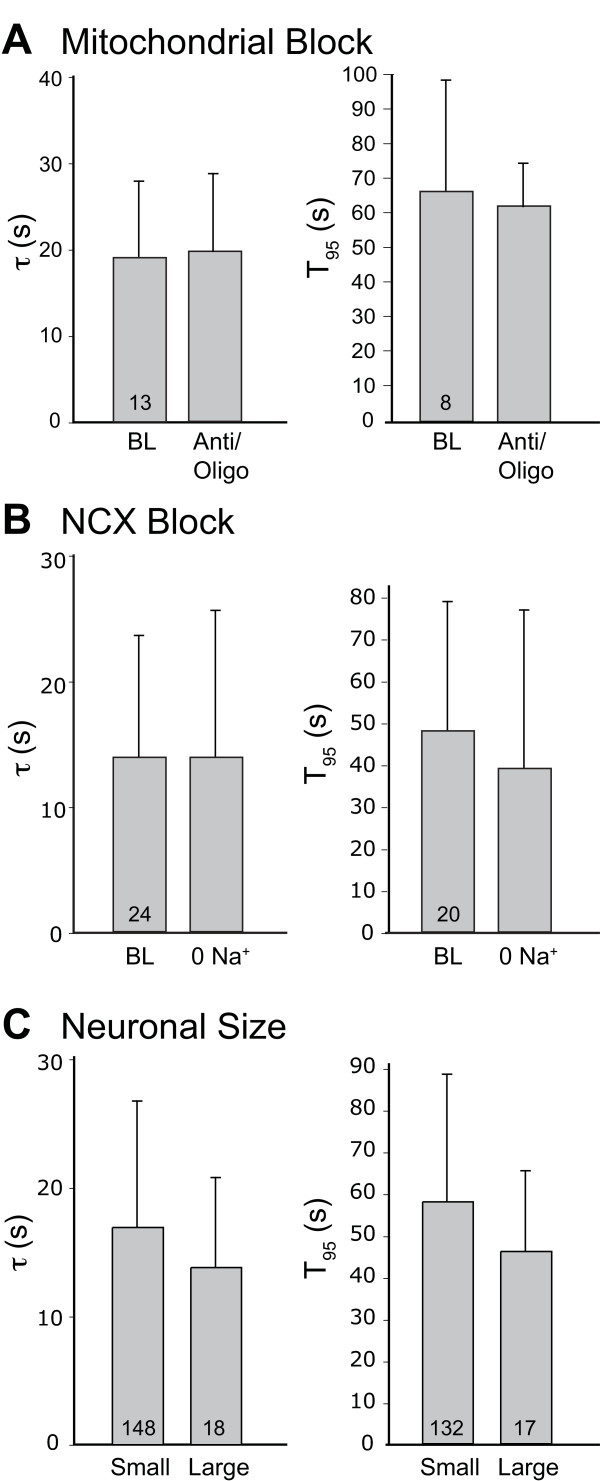
Roles of mitochondria, Na+/Ca2+ exchanger (NCX), and neuronal size. The recovery of [Ca2+]c from transients induced by application of high K+ solution (50 mM for 0.3 s) in thapsigargin-treated neurons was measured by recovery rate constant (τ) and by the time to achieve 95% recovery to baseline (T95). Blockade of mitochondrial function by combined application of antimycin (1 μM) and oligomycin (10 μM) for 3 min had no effect compared baseline values (BL) in the same neurons (A). Block of NCX by equimolar replacement of bath Na+ with N-methyl-d-glucamine (NMDG) also had no effect on recovery of transients (B). Neuronal groups with either large (diameter 39 ± 4 μm) or small (26 ± 3 μm) profiles did not differ in PMCA function (C). Mean ± SD; numbers in bars indicate n; no differences when tested by paired T-test (A, B) and simple T-test (C).